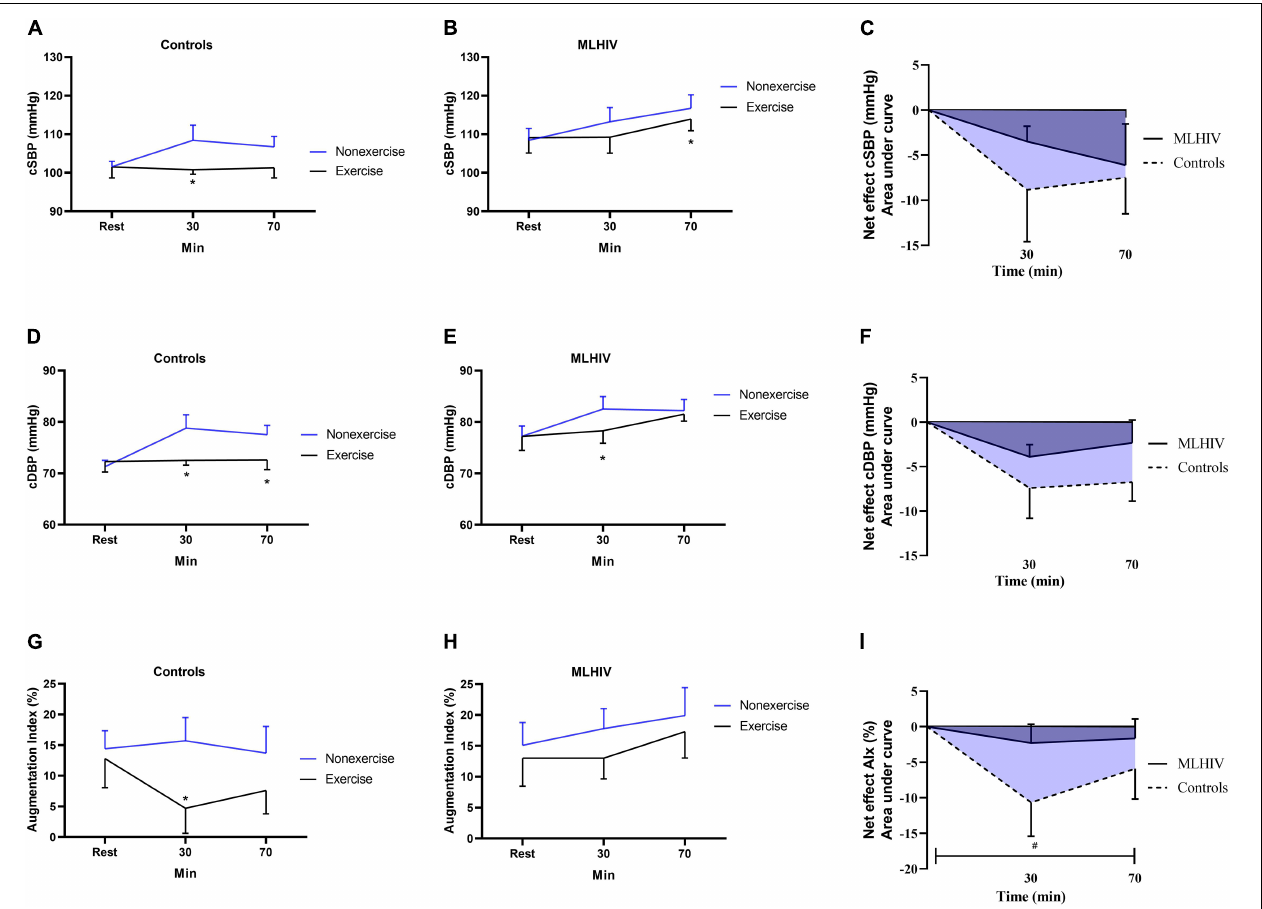
FIGURE 3 | Absolute values and exercise net effects of central systolic blood pressure (A–C) , central diastolic blood pressure (D–F) , and augmentation index (G–I) after exercise and non-exercise sessions in controls and men living with HIV (MLHIV). cSBP, central systolic blood pressure; cDBP, central diastolic blood pressure. * p < 0.05 for changes from baseline (exercise vs. non-exercise session) using linear mixed models. # p < 0.05 for differences between areas under the curves of controls vs.